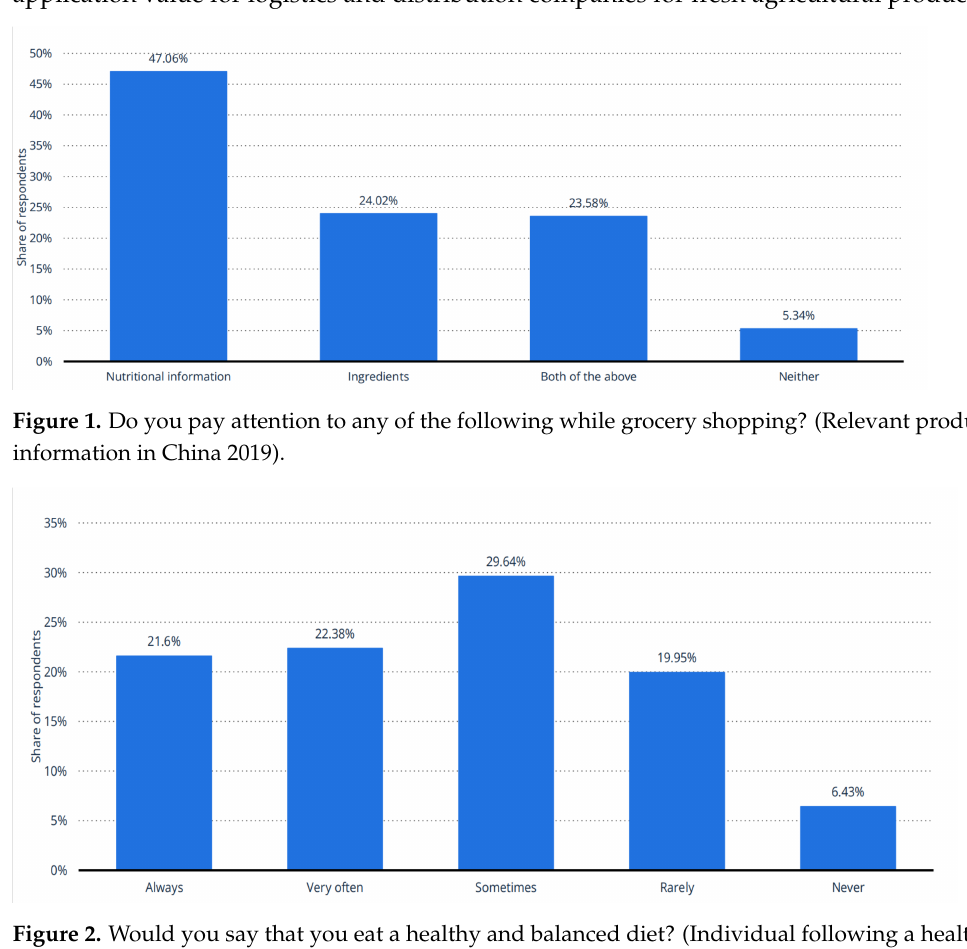
Figure 2. Would you say that you eat a healthy and balanced diet? (Individual following a healthy and balanced diet in China 2019, by